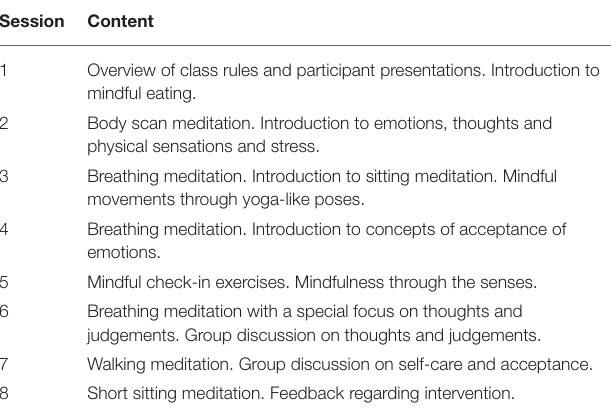
TABLE 2 | Mindfulness-based intervention session content. Session